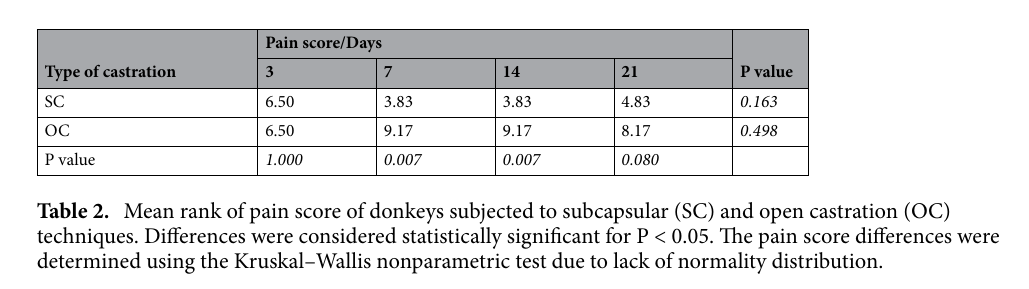
Figure 8. Standing ( A ), laying ( B ), feeding ( C ), and drinking ( D ) behavioral activities following subcapsular (SC) and open (OC) castration in donkeys during the 1st, 2nd, and 3rd weeks (W) post-castration. # Indicates significant difference between different groups, *Indicate significant difference at different time intervals within the SC, † Indicate significant difference at different time intervals within the OC.